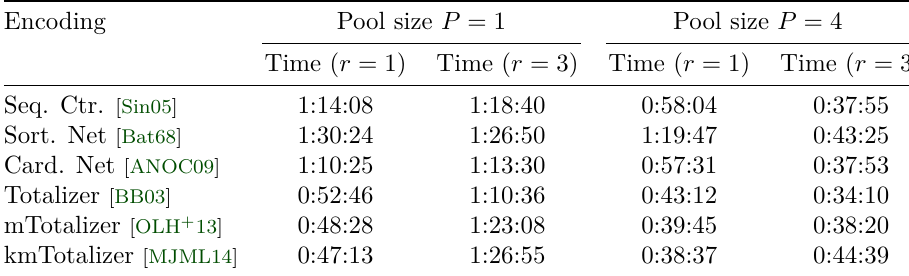
Table 7: Runtime comparison of cardinality encodings for R 0 = 3 rounds with ≤ 27 active S-boxes, fixing the S-box activity in round r ∈ { 1 , 3 } to one of P different pooled necklaces of weight 8, as described in Section 4. Results with Kissat on an Intel E5-4669 @ 2.20GHz . Encoding Pool size P = 1 Pool size P = 4 Time ( r = 1) Time ( r = 3) Time ( r = 1) Time ( r = 3) Seq. Ctr. [Sin05] Sort. Net [Bat68] Card. Net [ANOC09] Totalizer [BB03] mTotalizer [OLH + 13] kmTotalizer